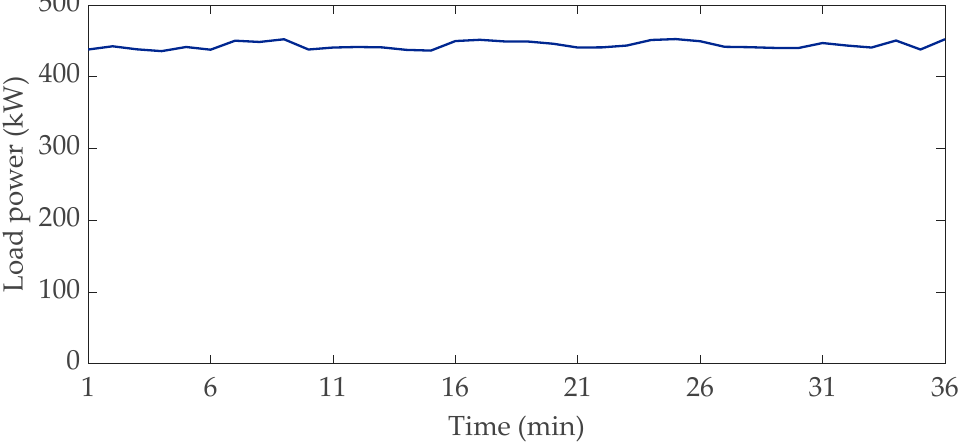
Figure 6. Profile of the load at bus #6 during the simulation period.